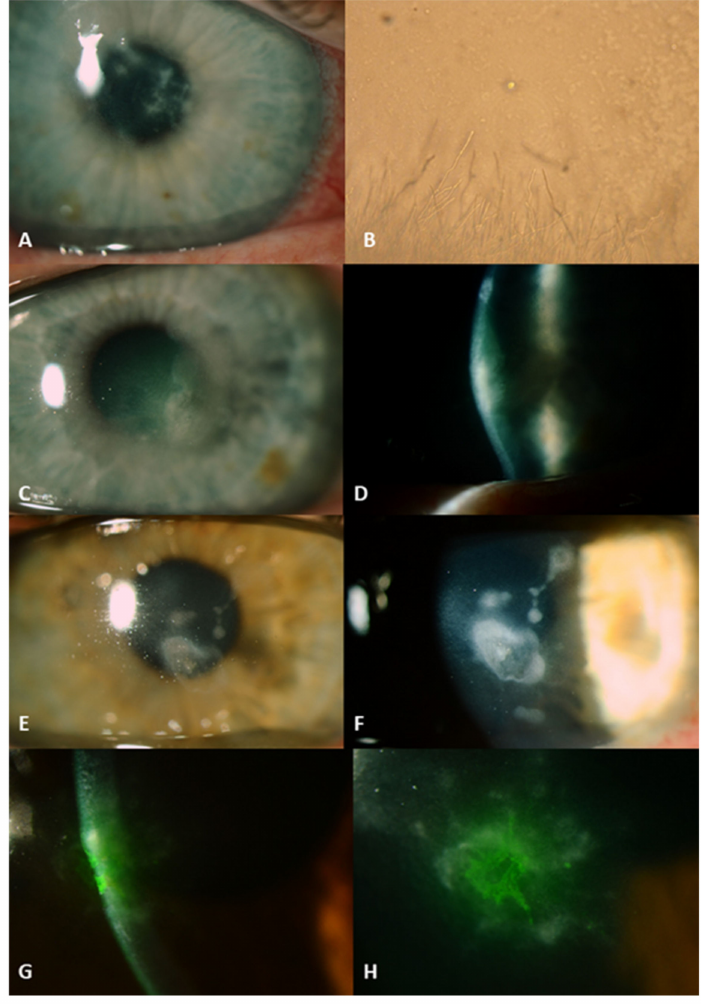
Figure 1. Fungal keratitis ulcers before the start of antifungal therapy with chlorhexidine digluconate. Patient from introduction: right eye with multiple infiltrates in the edematous corneal stroma ( A ). Culture of Acanthamoeba and F. solani on a nutrient agar with a lawn of Enterobacter aerogenes , magnification of 100 × ( B ). Patient 1: left eye with infiltrates in the corneal stroma ( C , D ). Patient 2: left eye with infiltrates in the corneal stroma ( E , F ). Patient 3: cornea of the right eye stained with fluorescein showing infiltrates in corneal stroma ( G , H ).